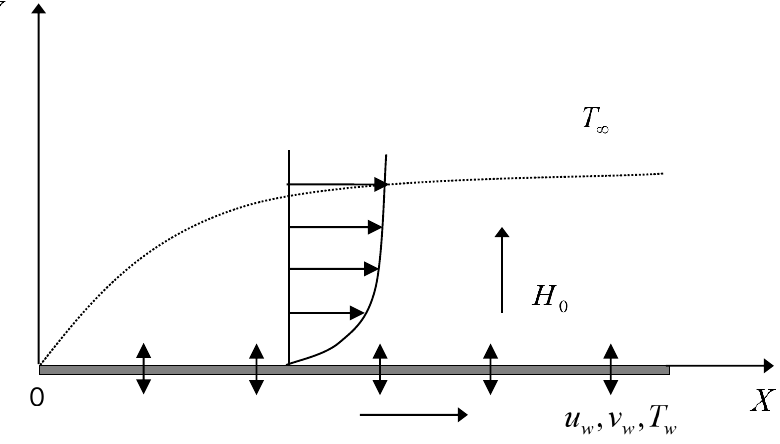
Figure 1. Flow geometry and coordinate